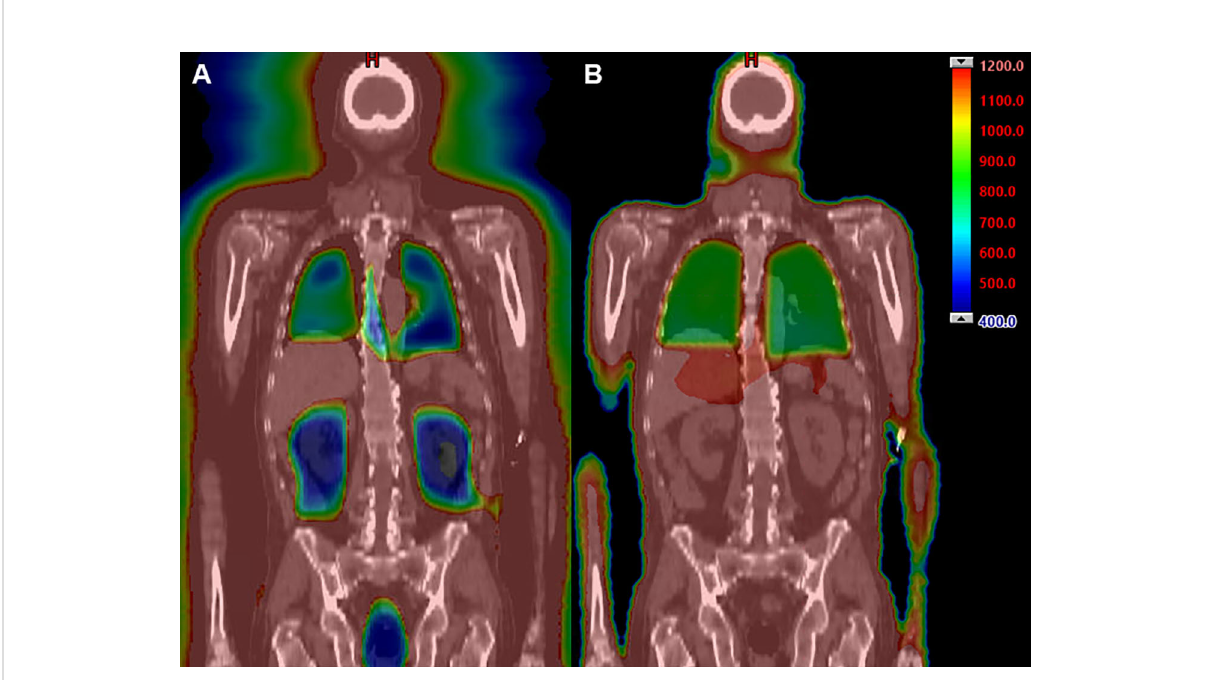
FIGURE 1 Example dose distribution (range 400 cGy [blue] to 1200 cGy [red]) using IMRT TBI (A) compared to standard TBI techniques (B)